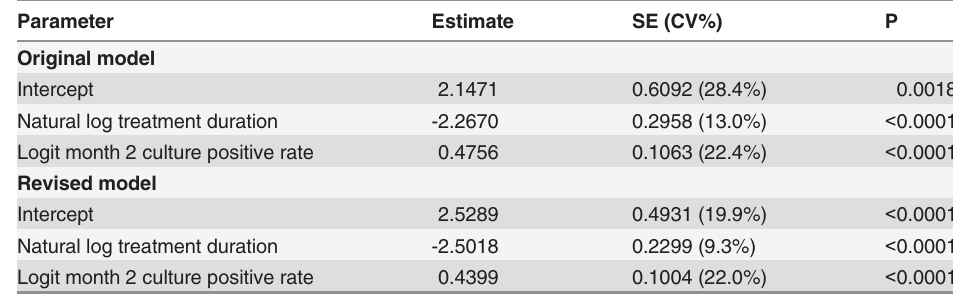
Table 3. Parameter estimates of original and revised meta-regression models.